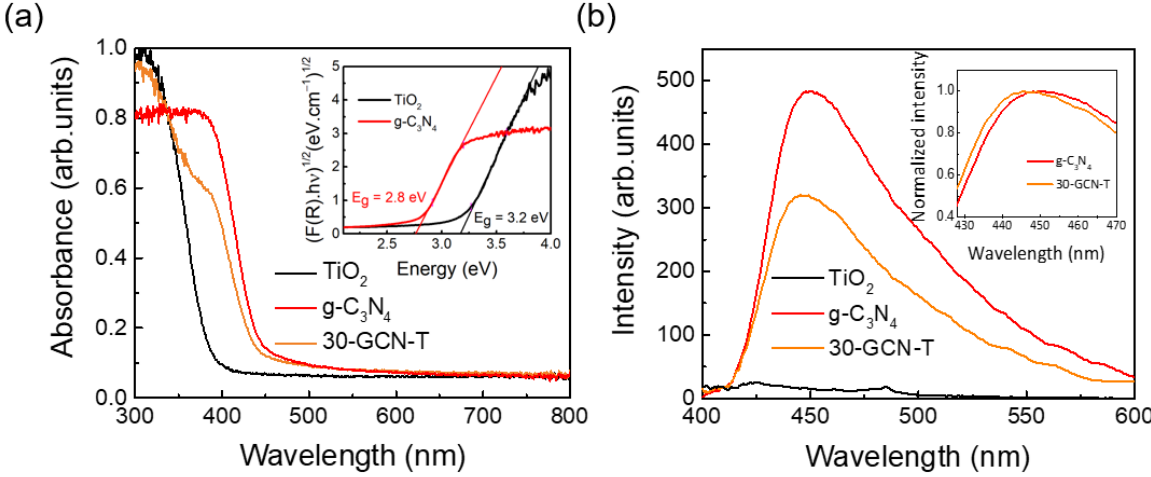
Figure 9. ( a ) RT absorption spectra of TiO 2 , g-C 3 N 4 and 30-GCN-T nanopowders. The inset shows the Kubelka–Munk plots (from DRS spectra of TiO 2 and g-C 3 N 4 nanopowders). For the determination of the optical band gap values, TiO 2 and g-C 3 N 4 materials were considered as indirect band gap semiconductors. ( b ) RT PL spectra of TiO 2 , g-C 3 N 4 and 30-GCN-T nanostructures from 400 to 600 nm using an excitation wavelength of 350 nm. The inset shows the RT PL spectra (normalized intensity as a function of the wavelength from 428 to 470 nm) of g-C 3 N 4 and 30-GCN-T nanostructures.